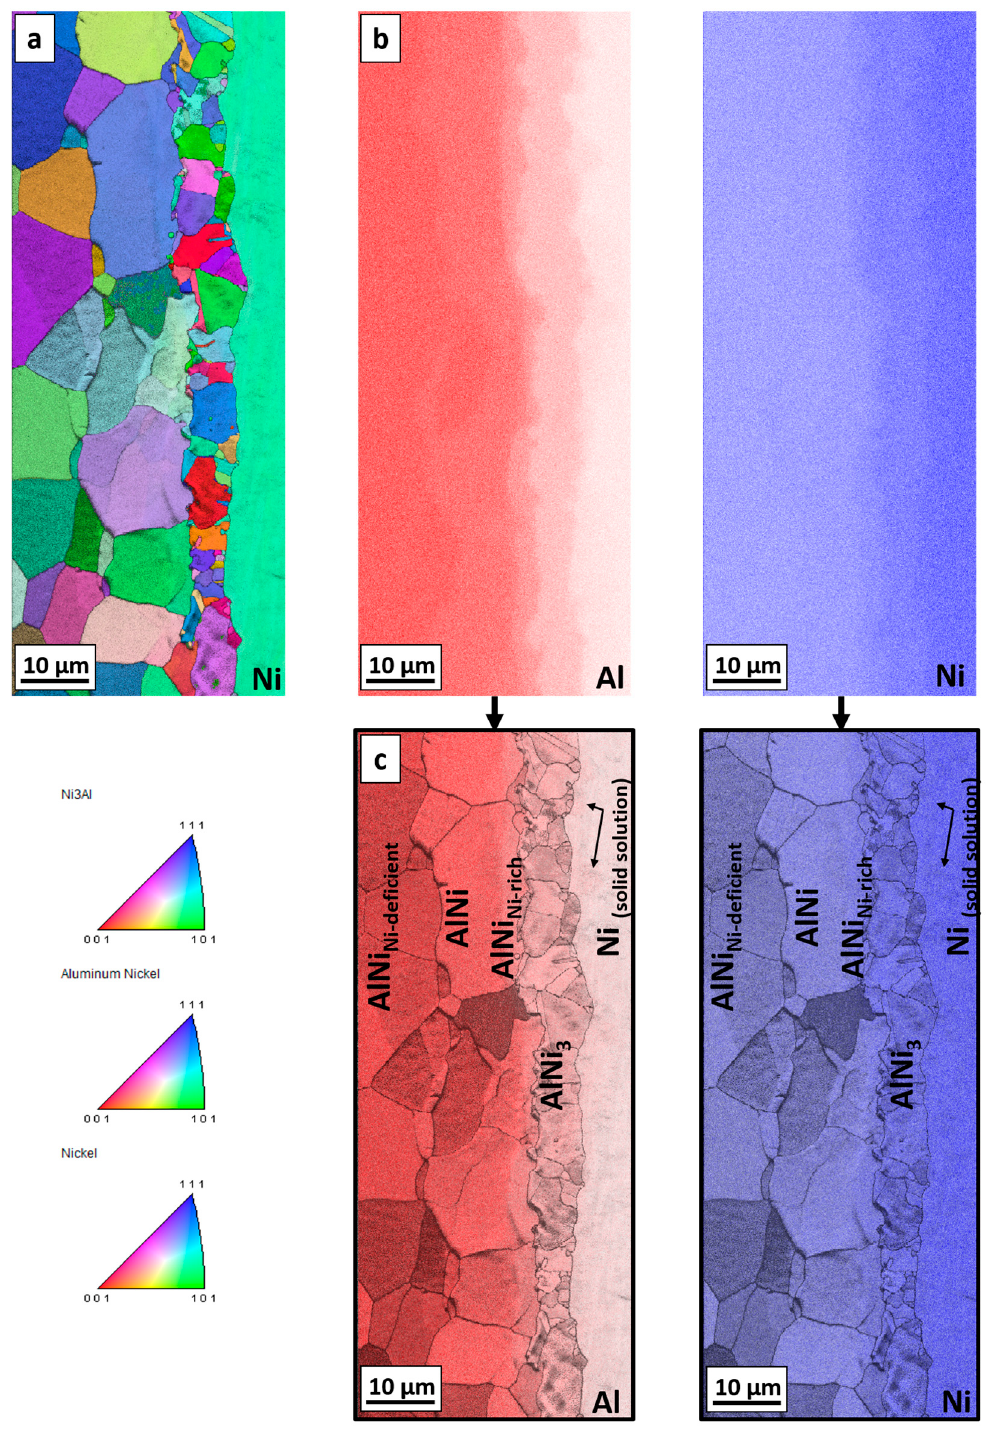
Figure 8. ( a ) EBSD map with ( b ) EDS maps of Al and Ni elements distribution for the sample annealed for 20 h at 720 °C. ( c ) The imposition of the EBSD indexing confidence map and EDS map analysis for Al and Ni elements.